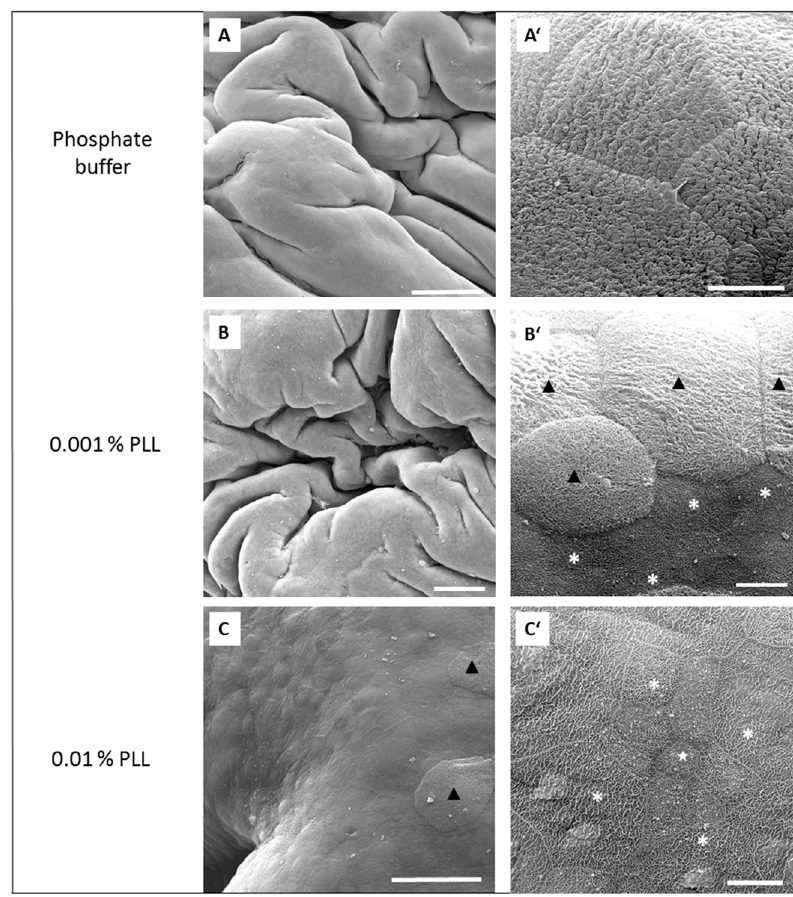
Figure 6. Representative SEM micrographs of the urothelium at the end of the regeneration period after the urothelium was exposed to phosphate buffer ( A and A’ ), 0.001% PLL (30–70 kDa) ( B and B’ ) or to 0.01% PLL (30–70 kDa) ( C and C’ ) in ex vivo experiments. Images A’, B’, and C’ show key features of the urothelium at higher magnification. Luminal surface of intact urothelium (A) consists of large, terminally differentiated superficial cells (umbrella cells) with specifically scalloped apical plasma membrane (A’). In images B, B’, C, and C’, the whole urothelial superficial layer was renewed after desquamation and composed of rare small cells with microvilli (white star in C’) and predominant cells with ropy ridges of apical plasma membrane (white asterisks in B’ and C’) between undesquamated umbrella cells (black triangles in C and B’). Scale bars: 200 µm ( A , B ), 50 µm ( C ), 20 µm ( A ’), and 10 µm ( B ’, C ’).